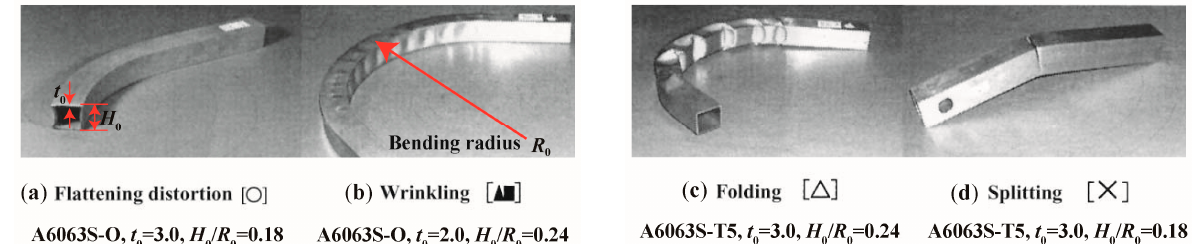
Figure 5. Typical defects occur during rotary draw bending of hollow profiles. Reproduced with permission from ref. [31]. Copyright 2002 Elsevier Science B.V.